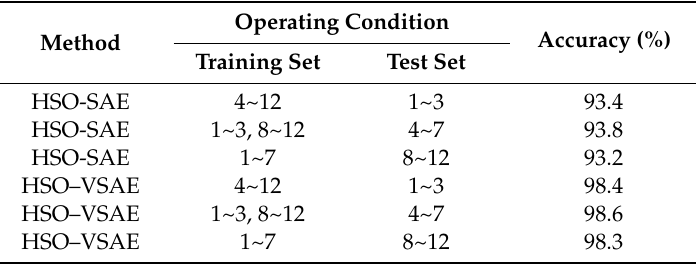
Table 6. Comparison under variable operating